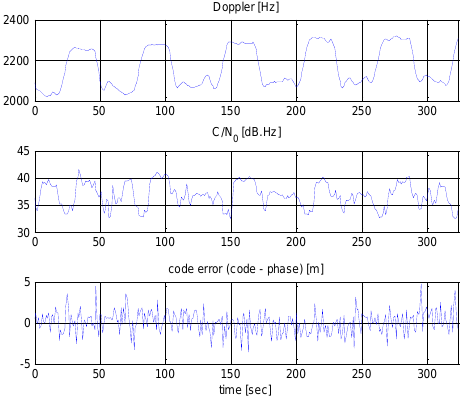
Figure 11. Doppler, C/N 0 and code error for E1 SVID 11. Table 2 shows the elevation angle, estimated C/N 0 and code and carrier phase measurements) for all visible